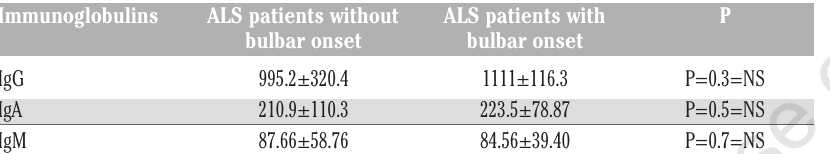
Table 3. Immunoglobulin levels (mean± standard deviation) in serum of amyotrophic lat- eral sclerosis patients with and without bulbar onset. Immunoglobulins